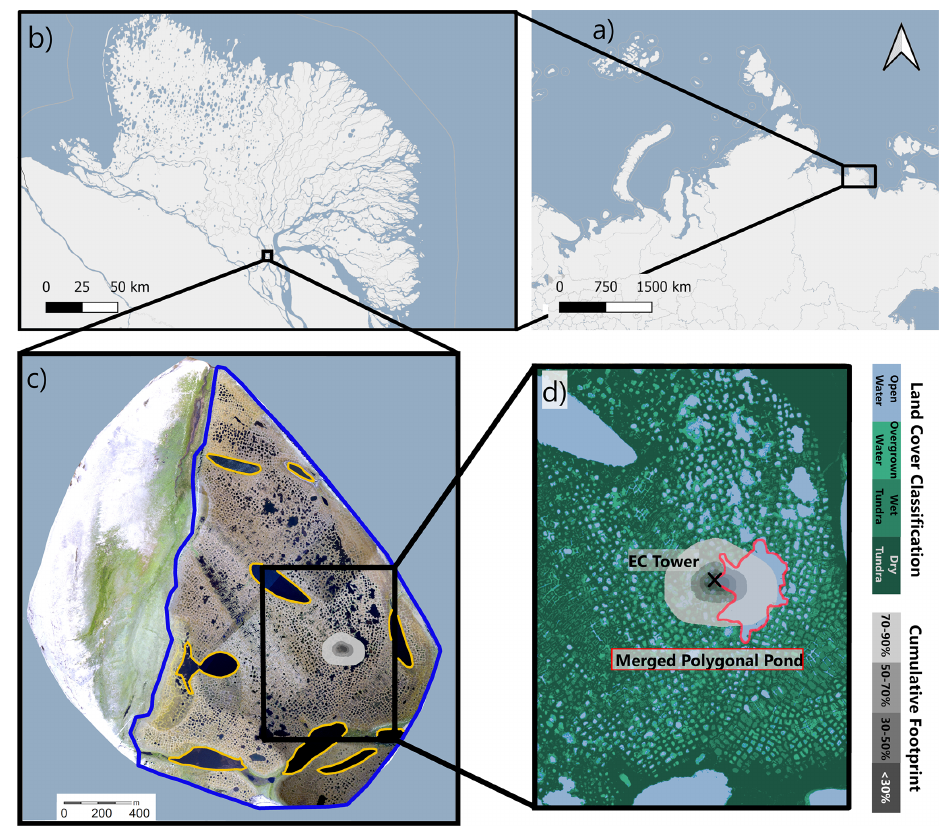
Figure 1. The location of the study site in Russia is shown in (a) , and the location of Samoylov Island within the Lena River delta is shown in (b) . Samoylov Island is shown in (c) ; the surrounding Lena River appears in light blue. The outline of the river terrace land-cover classification (Sect. 2.4.1) is indicated by the blue line. We focus on the polygonal tundra; however, large lakes are excluded (circled in yellow). In (d) , the land-cover classification is drawn in blue (open water) and green (dark green: dry tundra; medium green: wet tundra; light green: overgrown water) shades. The merged polygonal pond studied here is outlined in red. The location of the EC tower is marked by a black cross. The cumulative footprint (see Sect. 2.4.2) is shown in gray shades. Of the flux, 30% likely originated from within the dark gray area, 50% from within the medium dark gray area, 70% from within the medium light gray area, and 90% from within the light gray area. Map data from © OpenStreetMap contributors 2020, distributed under the Open Data Commons Open Database License (ODbL) v1.0 (a, b) and modified based on Boike et al. (2012) (c, d)